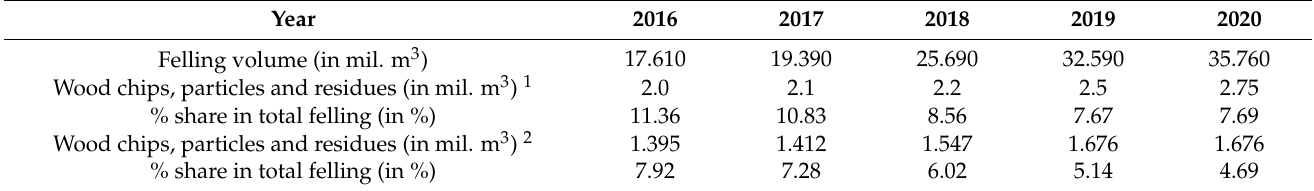
Table 4. Annual available volume of wood chips in 2016–2020 related to total felling.